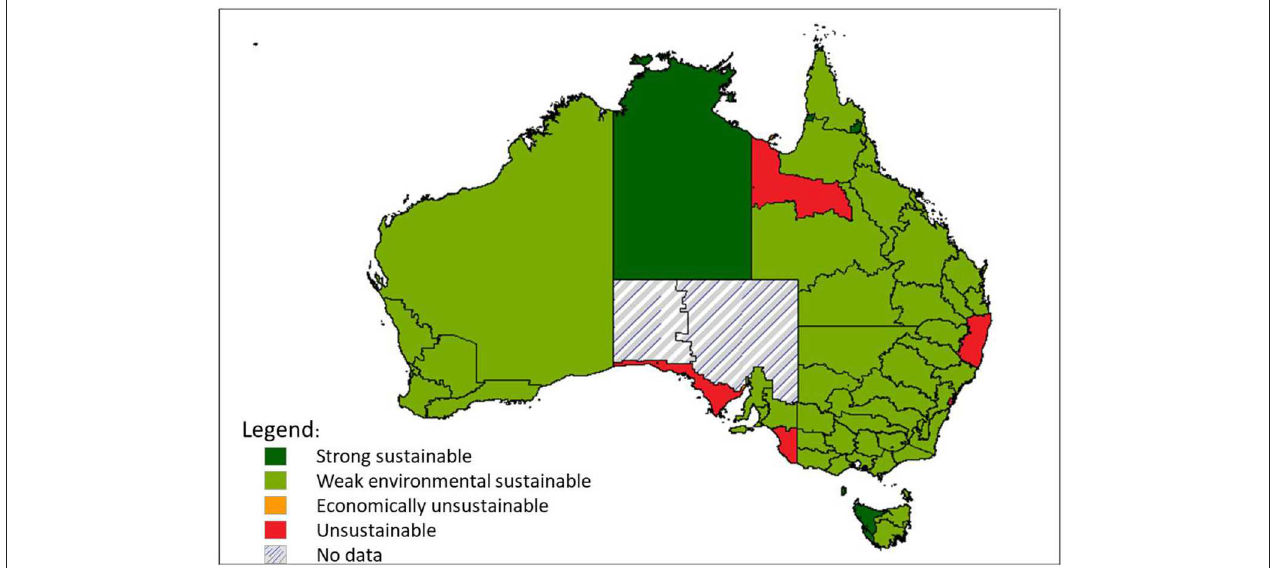
FIGURE 4 | Map of the sustainability paradigm of the irrigation practice using surface water.